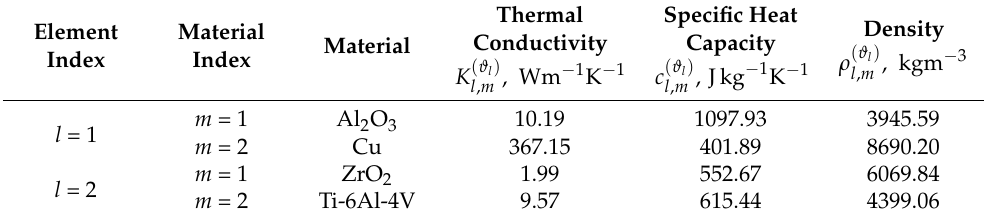
Table 4. Material properties at volume temperature ϑ l , l = 1,2.